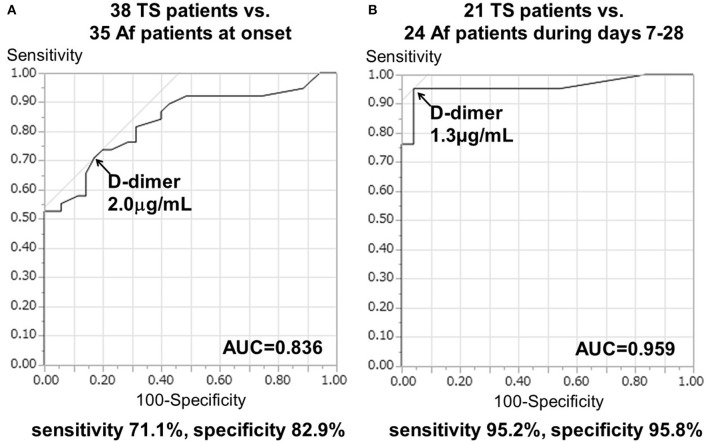
Receiver operating characteristic (ROC) curve analysis of D-dimer levels to differentiate the TS group from Af alone (A) at onset and (B) during days 7–28 after stroke onset. AUC, area under the ROC curve.